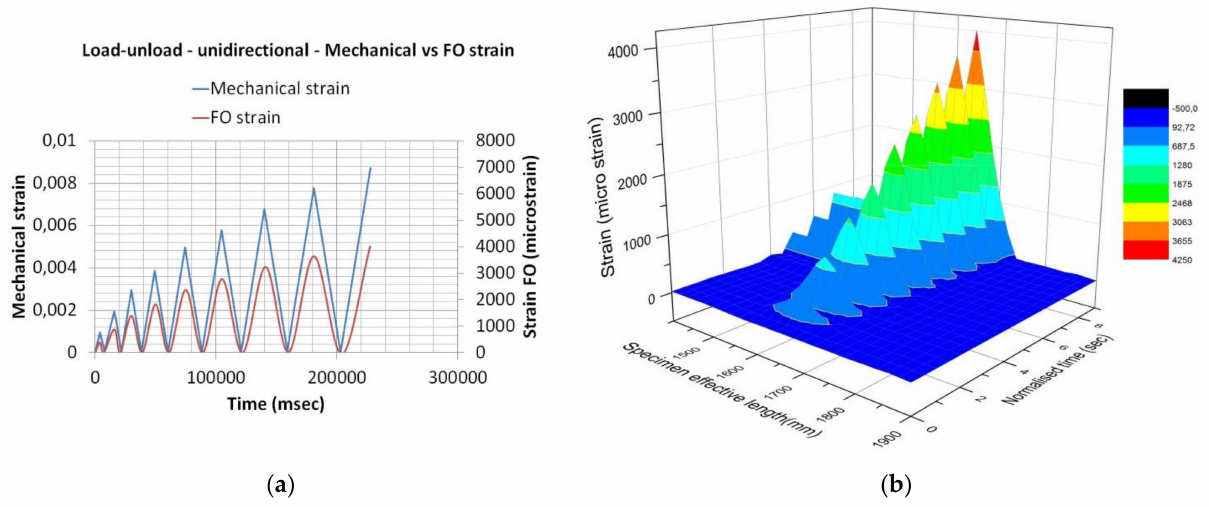
Figure 14. ( a ) Load–unload curve for smart UD specimen; ( b ) 3-D load–unload curve for smart UD